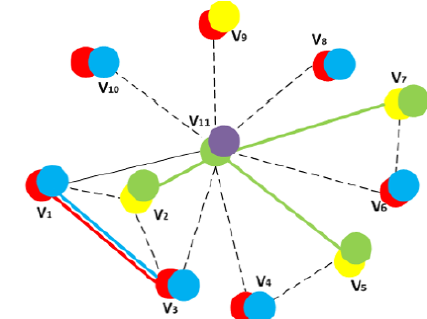
Figure 5. Network topology utilizing a diverse software distribution. Dashed or solid lines mean two nodes can communicate directly (e.g., through TCP/IP or being friends in a social network). Solid lines further indicate two nodes share at least one common